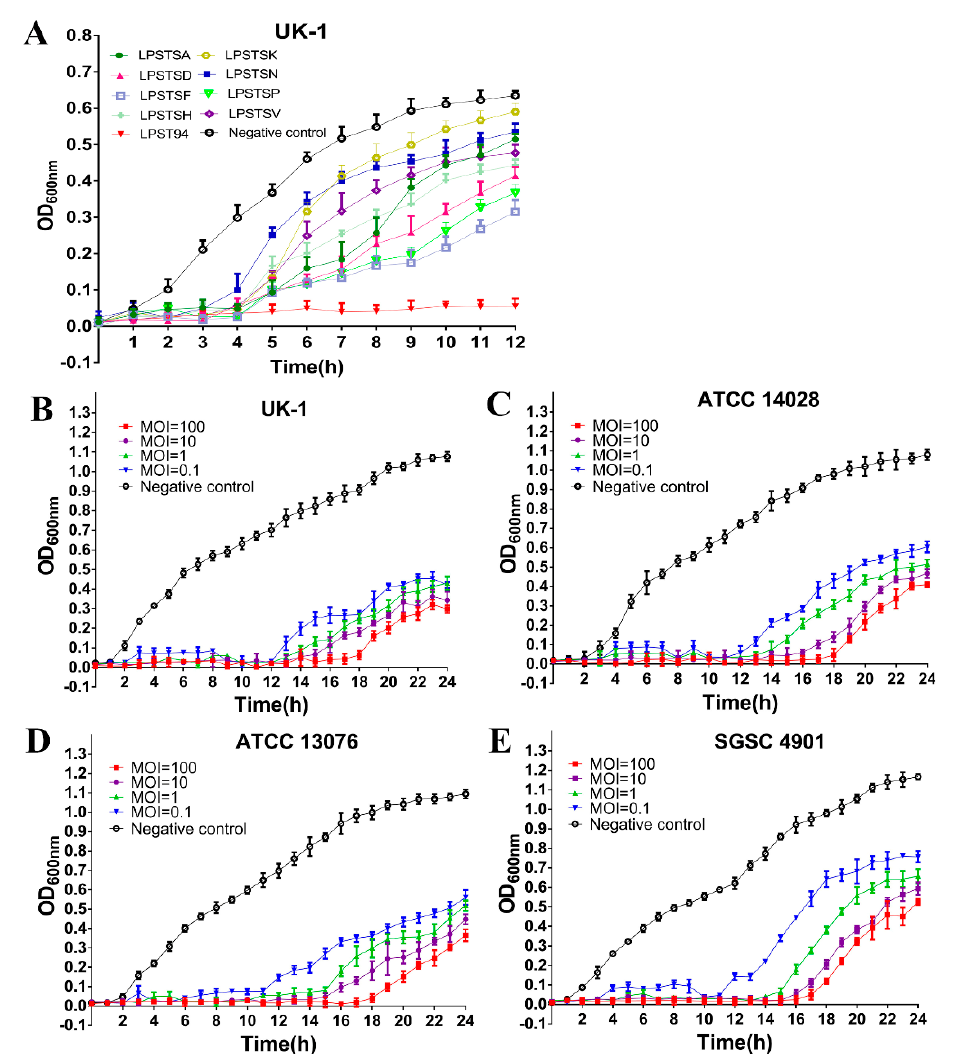
Figure 1. ( A ) Comparison of the lytic ability of selected phages using S. enterica serovar Typhimurium (UK-1) as a host at multiplicity of infection (MOI) of 1 in tryptone soy broth; Lytic ability of phage LPST94 to lyse S. Typhimurium and S. Enteritidis in tryptone soy broth medium at MOIs of 100, 10, 1, and 0.1 at 37 ◦ C in vitro. ( B ) S. Typhimurium UK-1, ( C ) S. Typhimurium ATCC 14028, ( D ) S. Enteritidis ATCC 13076, and ( E ) S. Enteritidis SGSC 4901. Values represent means with the standard deviation of three replicates of each time